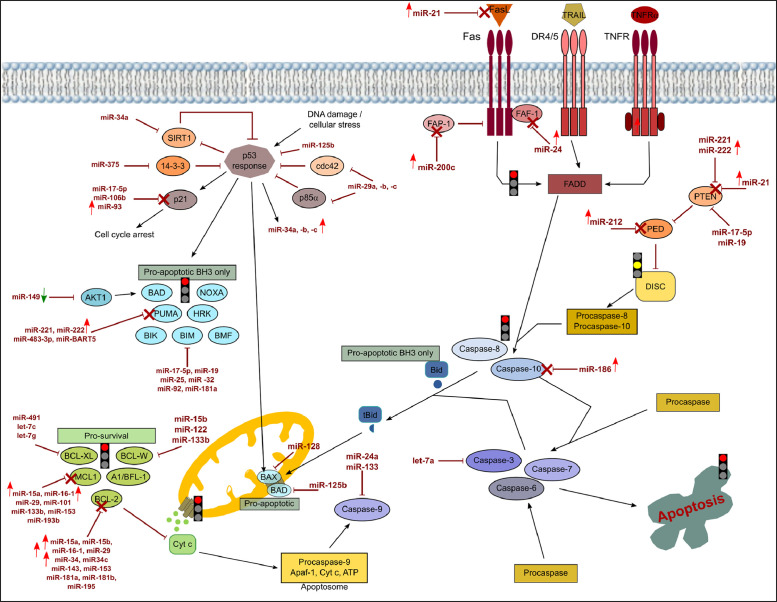
The core apoptotic pathway and its regulation by miRNAs in THP-1 cells exposed to the lower dose of CdS QDs. The figure depicts events in the intrinsic and extrinsic apoptotic pathways. In the whole pathway, point and block arrows indicate activation or inhibition, respectively. In the experimental conditions, the arrows next to the miRNAs indicate an increase or decrease of the miRNA. A red arrow indicates an increase in a specific miRNA and its target repressed is indicated with a red cross. A green arrow indicates a decrease with lack of repression of its specific target. As a result, the specific step is locked (red light) or could be unlocked (yellow light). The expression of most of the gene participants in the pathway are blocked by an increase in regulatory miRNAs.Note: DIANA-Tarbase database and DIANA-mirPath were used to obtain the data to create this chart.